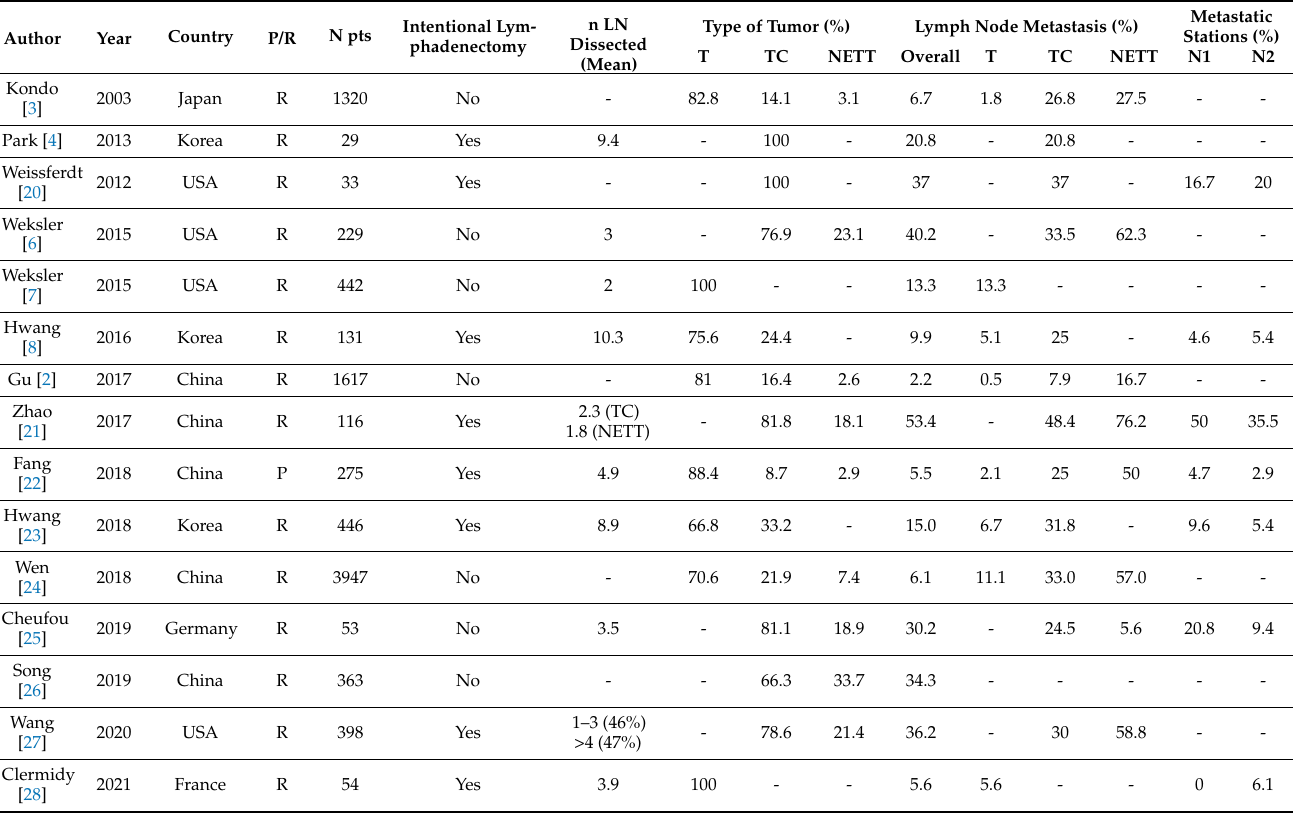
Table 1. Studies comparing data about lymph node metastasis in thymic tumors over the last 20 years.